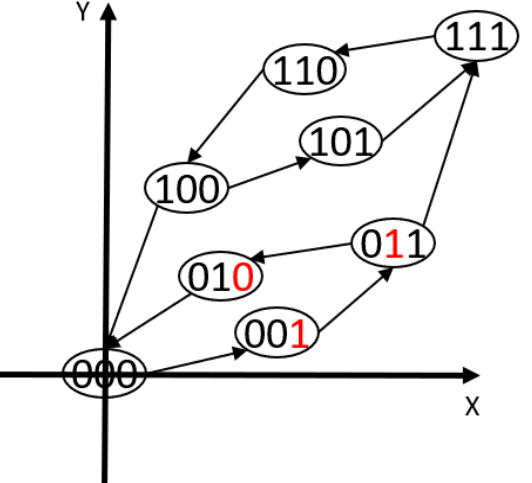
Figure 4. A digitized representation of the classical PI hysteresis model with 3